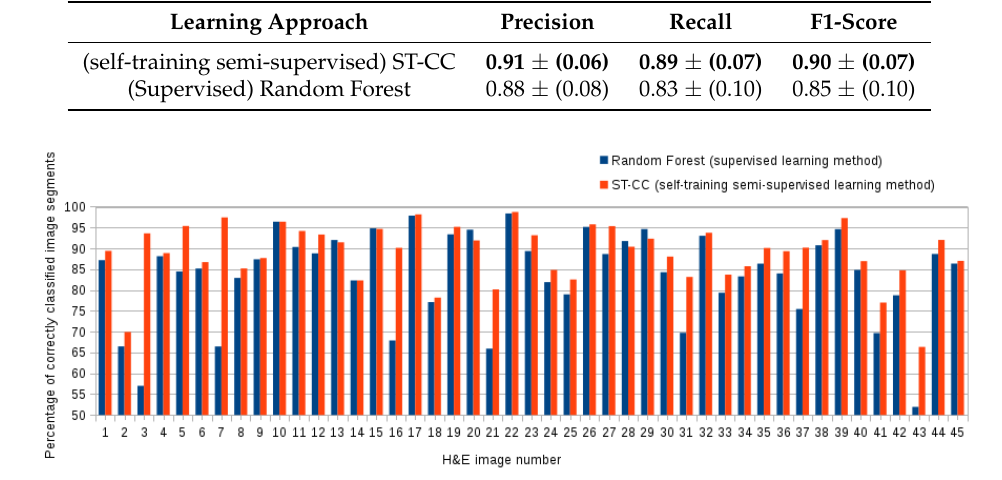
Figure 3. The chart illustrates the percentage of correctly classified instances ( y -axis) in each of the forty-five tested haematoxylin and eosin (H&E) images ( x -axis) for the Random Forest supervised method (blue bars) and the self-training semi-supervised method (ST-CC) (red